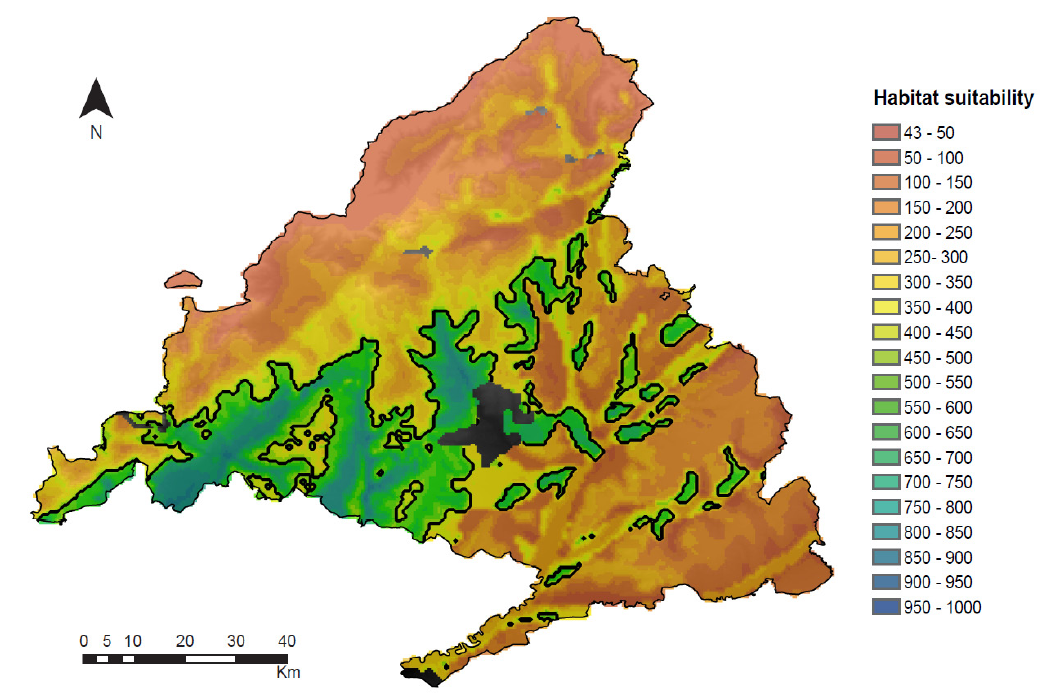
Figure 2. Suitability map of Himantoglossum robertianum in Madrid according to the consensus